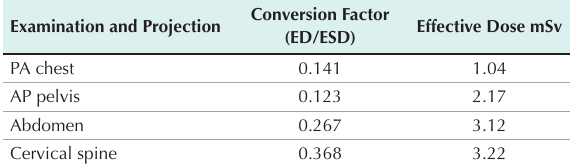
Table 2. ED Conversion Factors for Selected Examinations and Projections